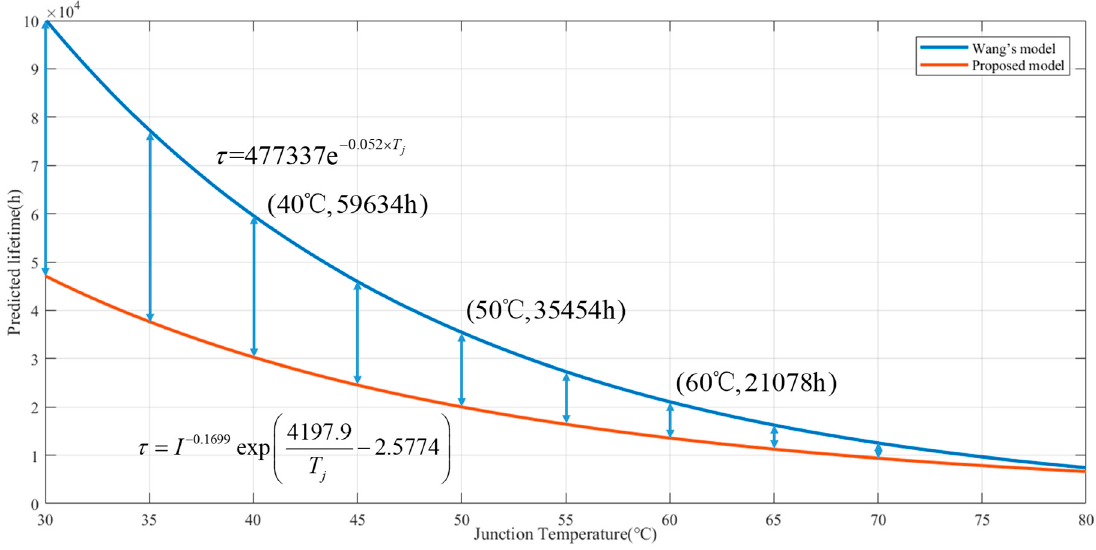
Figure 2. Comparison of Wang’s model [31] and the model proposed in this paper.